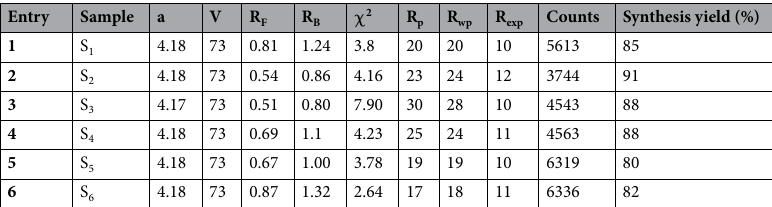
Table 1. Synthesized nanocatalysts Rietveld analysis and unit cell parameters.